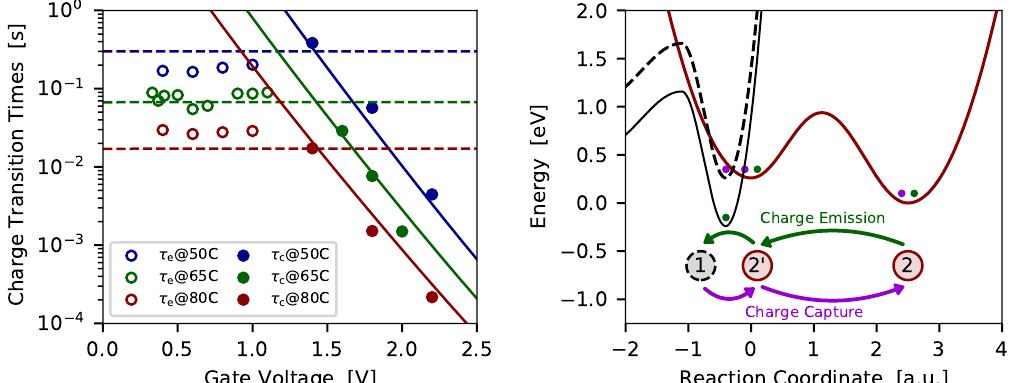
Figure 11. ( left ) The charge trapping kinetics for a fixed trap is shown at different temperatures (symbols ... measurement data, lines ... simulations). As can be seen, the fixed trap shows bias dependent charge capture times, but bias independent charge emission times. ( right ) To explain this behavior three states of the defect model are used and the pathways for charge capture an emission are shown together with the corresponding approximation for the potential energy surfaces.